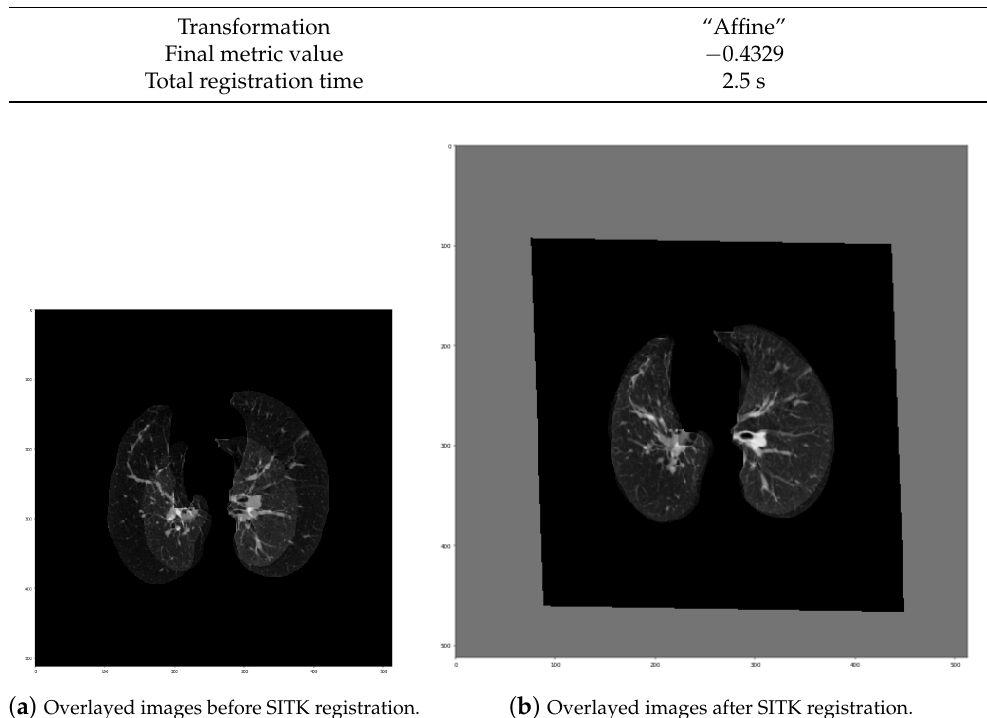
Figure 16. Illustration of the registration results using the SimpleITK